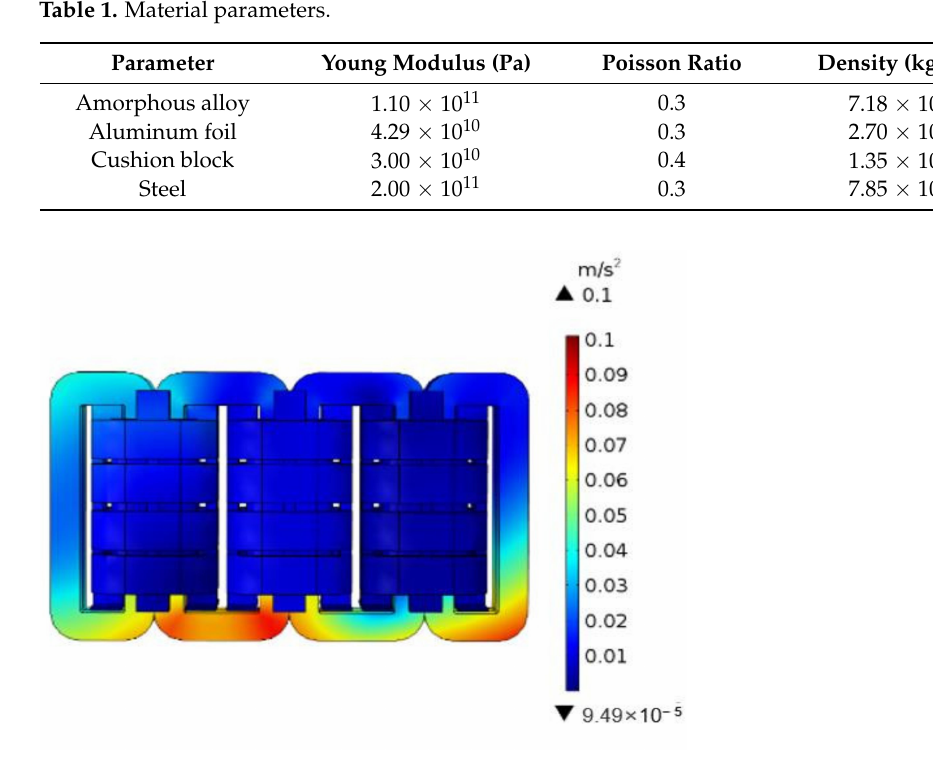
Figure 7. Vibration acceleration of core under rated no-load